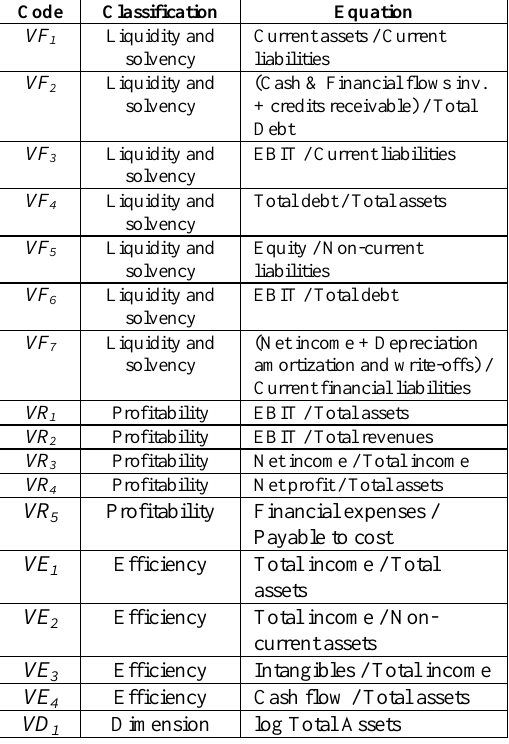
Table 3. Financial ratios